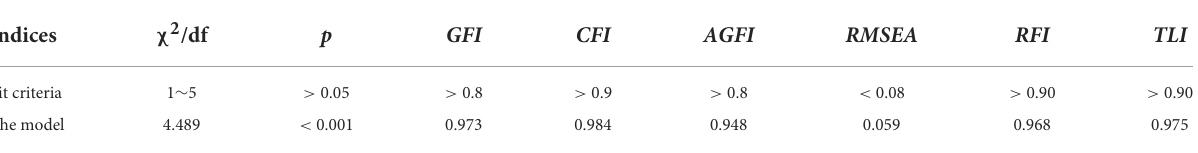
TABLE 4 Model fitting indexes and fit criteria.